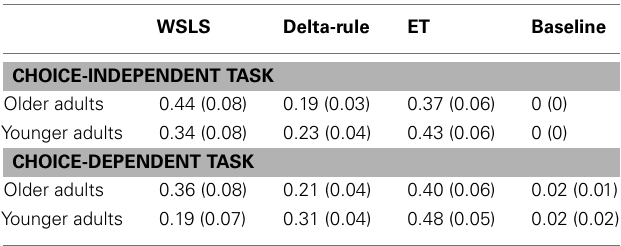
FIGURE 4 |Average proportion of the optimal cumulative payoff earned by participants in each